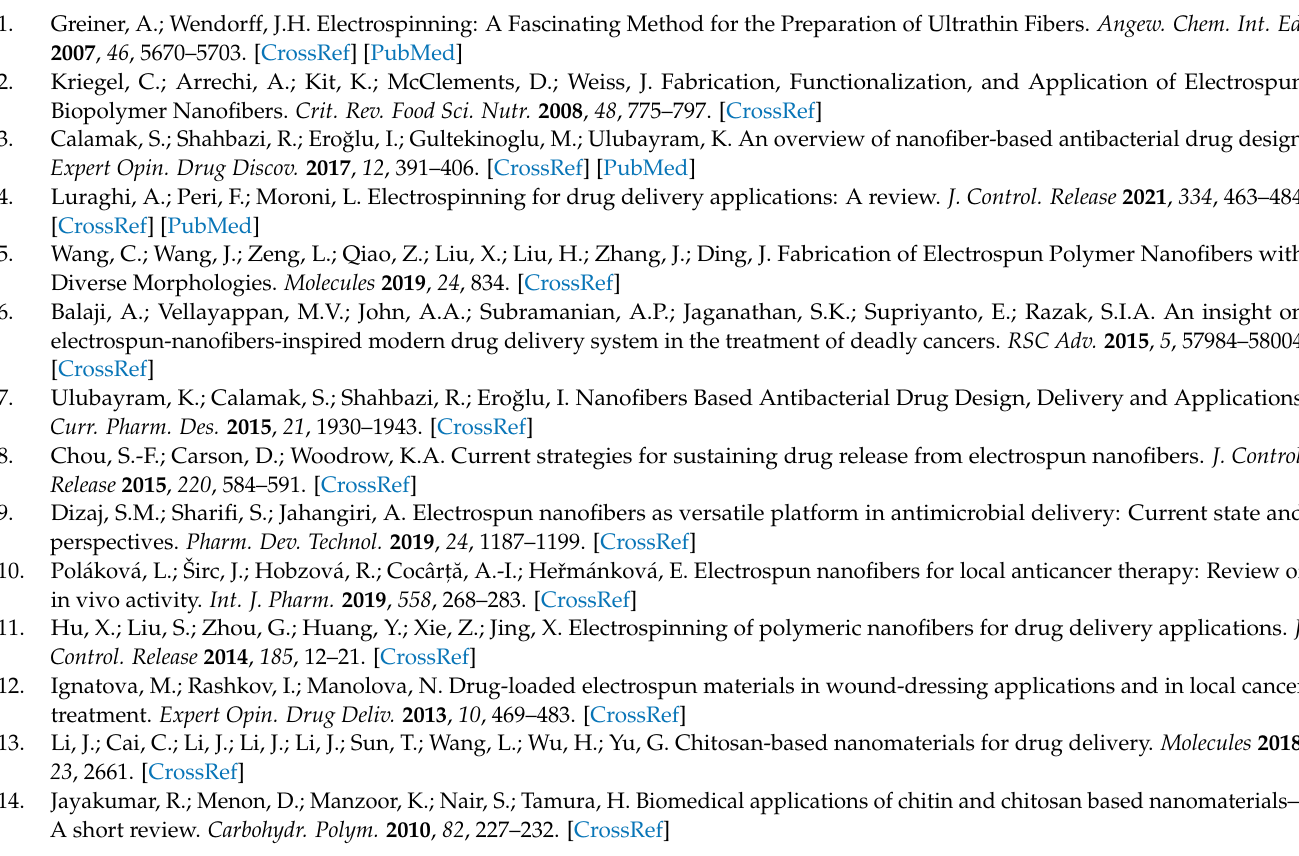
SQ-containing mat, Figure S9: Korsmeyer–Peppas model of SQ, SQ.Cu 2+ (Fe 3+ ) release from SQ- containing mats and their complexes, Figure S10: SEM micrographs of mats that have been incubated in S. aureus cell culture, Figure S11: Fluorescence microscopic images of HeLa tumor cells stained with DAPI after treatment with crPVA mat, cr(PVA/Ch) mat, Ch, crosslinked SQ-containing mats and their complexes or with SQ and its